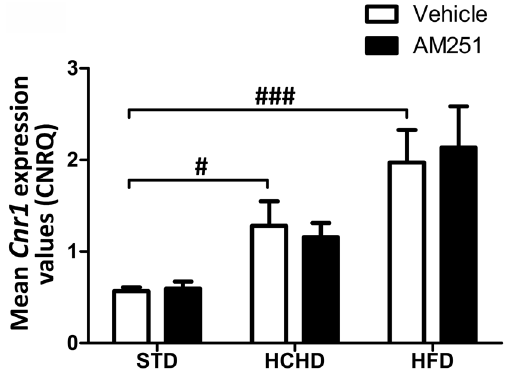
Figure 2. Effect of obesogenic diets and AM251 on Cnr1 expression in PrAT. The Cnr1 gene expression was determined by qPCR analysis in PrAT of STD, HCHD or HFD-fed animals after 14-day exposure to vehicle or AM251 (3 mg/kg, daily, i.p.). The Cnr1 expression was normalized to the geometric mean expression of the two reference genes Rpl19 and Sp1. The average calibrated normalized relative Cnr1 gene expression values in arbitrary units (CNRQ 6 SEM) is shown in the figure (n=8 rats per group). Columns are means 6 SEM. Differences between diets were analyzed by one-way ANOVA and Bonferroni’s post- hoc test, and comparisons between groups treated with AM251 or vehicle were analyzed by Student’s t test. # p , 0.05 and ### p , 0.001 denote significant differences compared with the STD-fed group treated with vehicle.